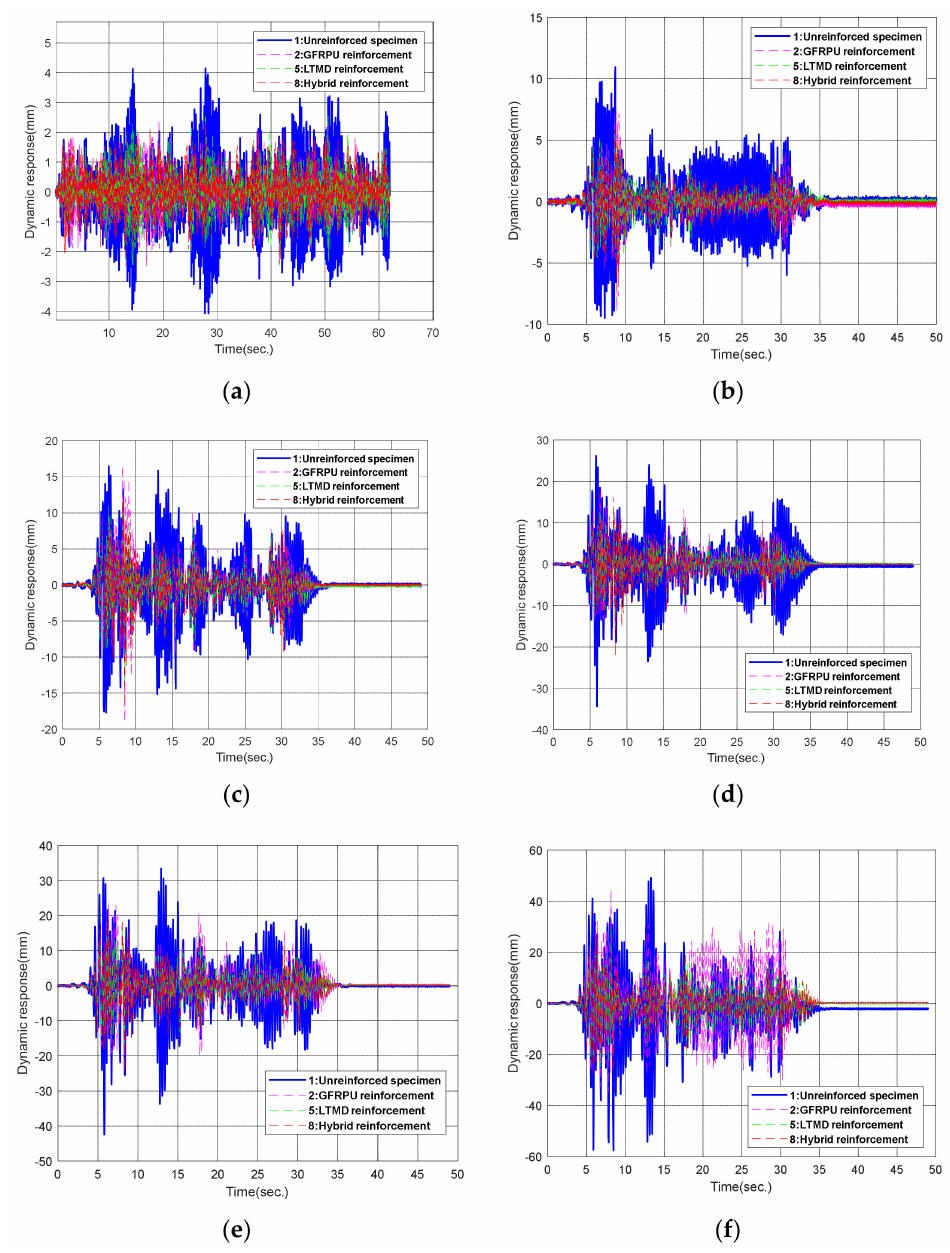
Figure 17. Displacement response curves: ( a ) random, ( b ) 50% El Centro, ( c ) 100% El Centro, ( d ) 120% ElCentrol, ( e ) 150% ElCentrol, ( f ) 200% El